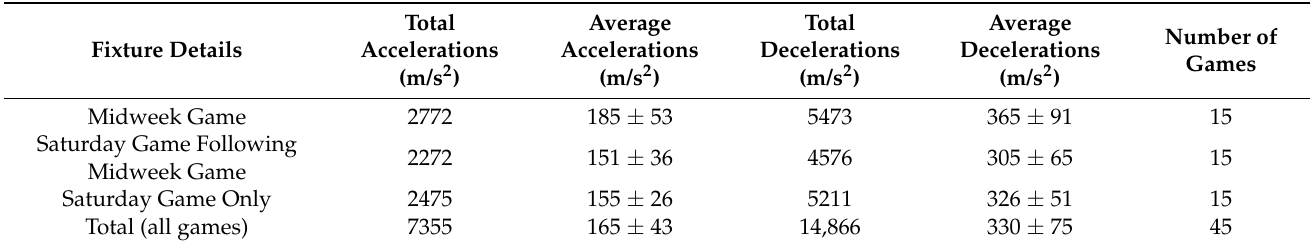
Table 1. Frequency of team high-intensity (>3 m/s 2 ) accelerations and decelerations (mean ± SD) for weeks associated with